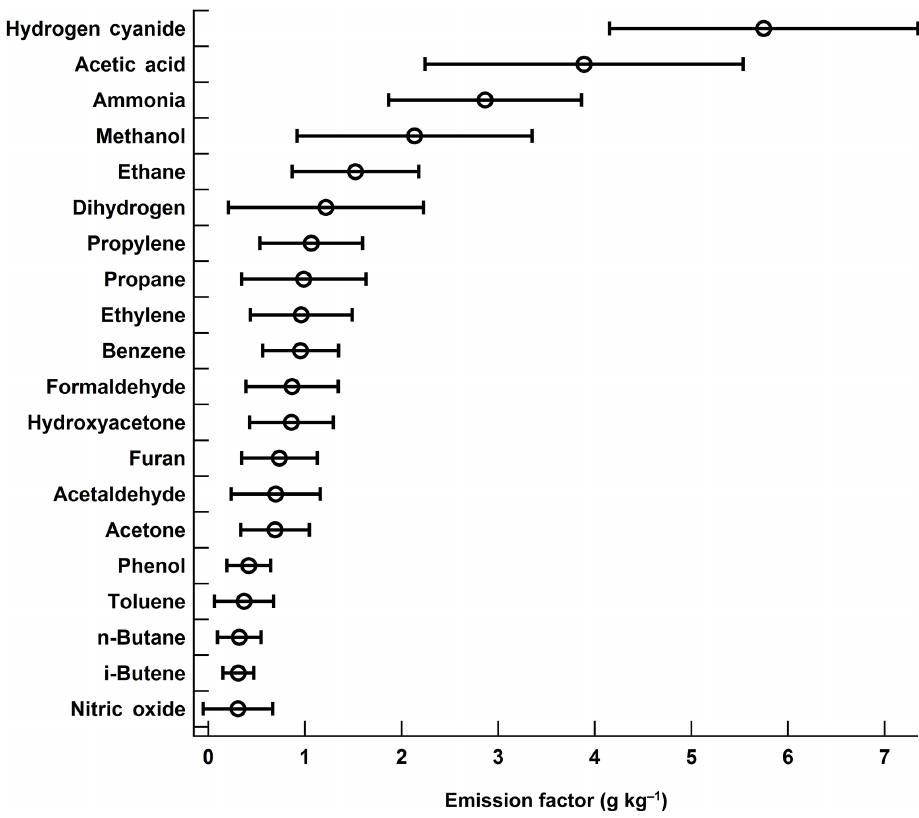
Figure 2. The emission factors (gkg − 1 ) and ± 1 standard deviation for the 20 most abundant trace gases (excluding CO 2 , CO, CH 4 ) in this dataset.